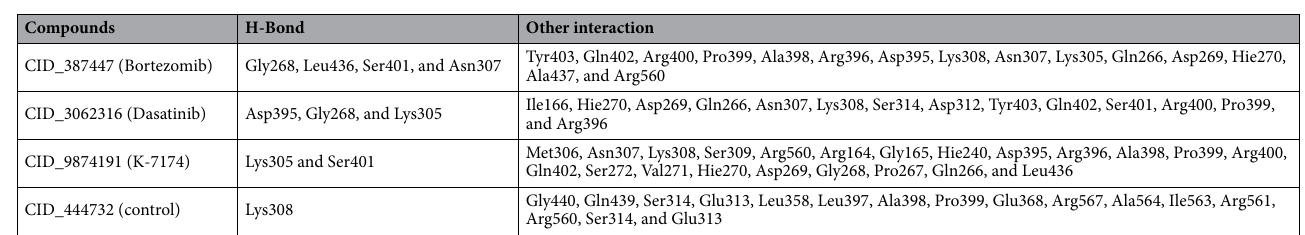
Table 3. A list of various interactions and interacting residues of MCM7 with the compounds were logged from respective docked complexes.